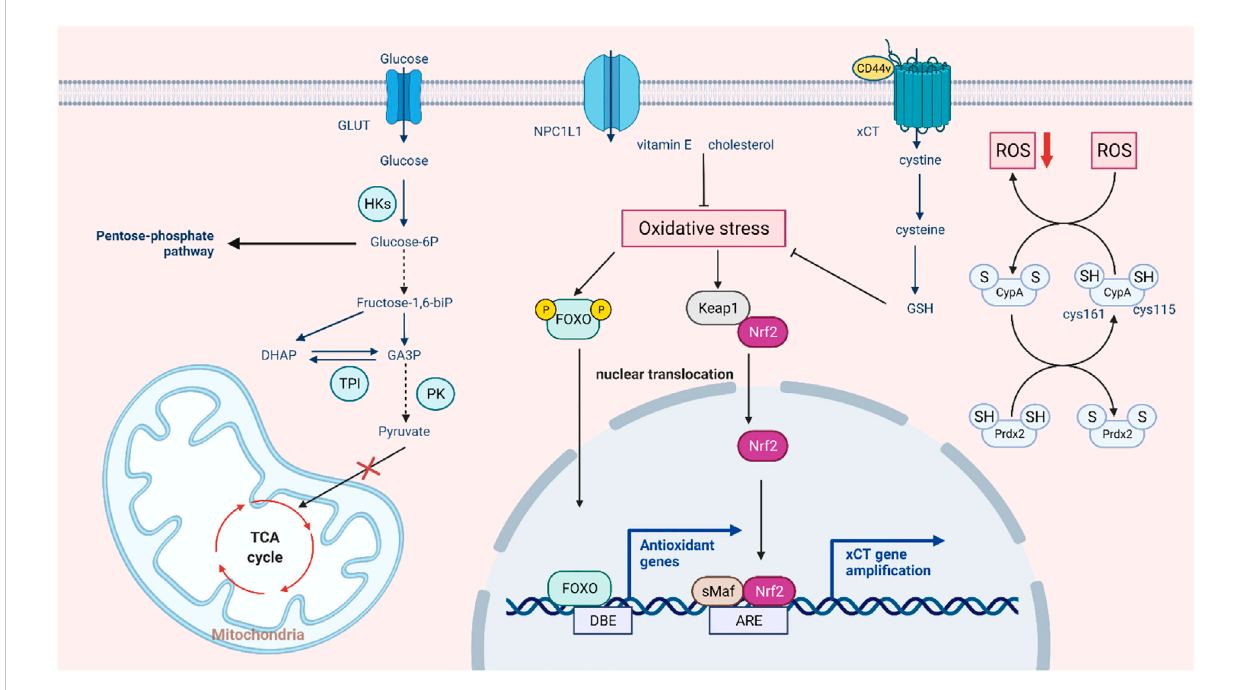
FIGURE 2 IntrinsicpathwaysinvolvedinROS-mediateddrugresistance.Intheaerobicstate,tumorcellsstillpreferentiallychooseglycolysisandconversionto lacticacid,andROSregulatethethreekeyenzymesinthisprocess.Inresponsetoexcessiveoxidativestress,theglycolyticpathwaypartlyswitchestothe pentose phosphate pathway, and the tumor also activates the antioxidant system to prevent cell death by allowing the translocation and activation of NRF2 and FOXO and enhancing XCT transport function to promote GSH synthesis. In addition, some non-classical antioxidant pathways, such as autooxidation modi fi cation of CypA and compensatory transport of NPC1L1, can also buffer oxidative